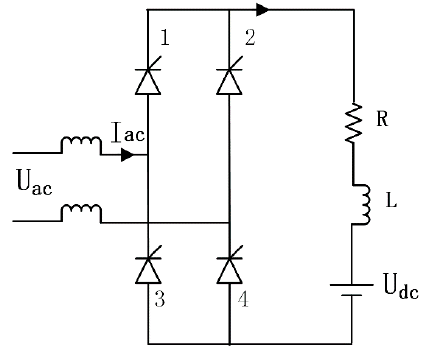
Figure 1. Schematic circuit of a single-phase bridge converter.